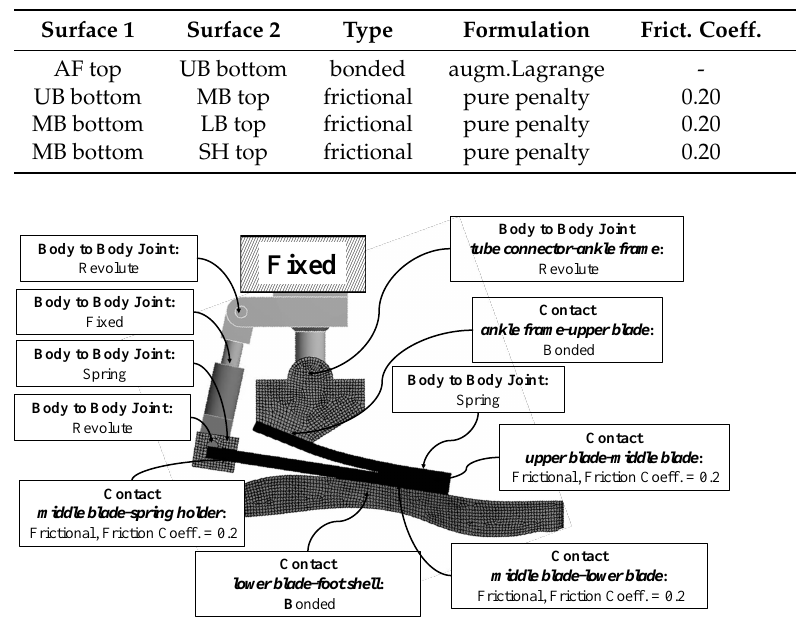
Table 6. Contacts’ properties. See also Figure 15. AF = ankle frame; UB = upper blade; MB = middle blade; LB = lower blade; SH = spring holder; TC = tube connector.